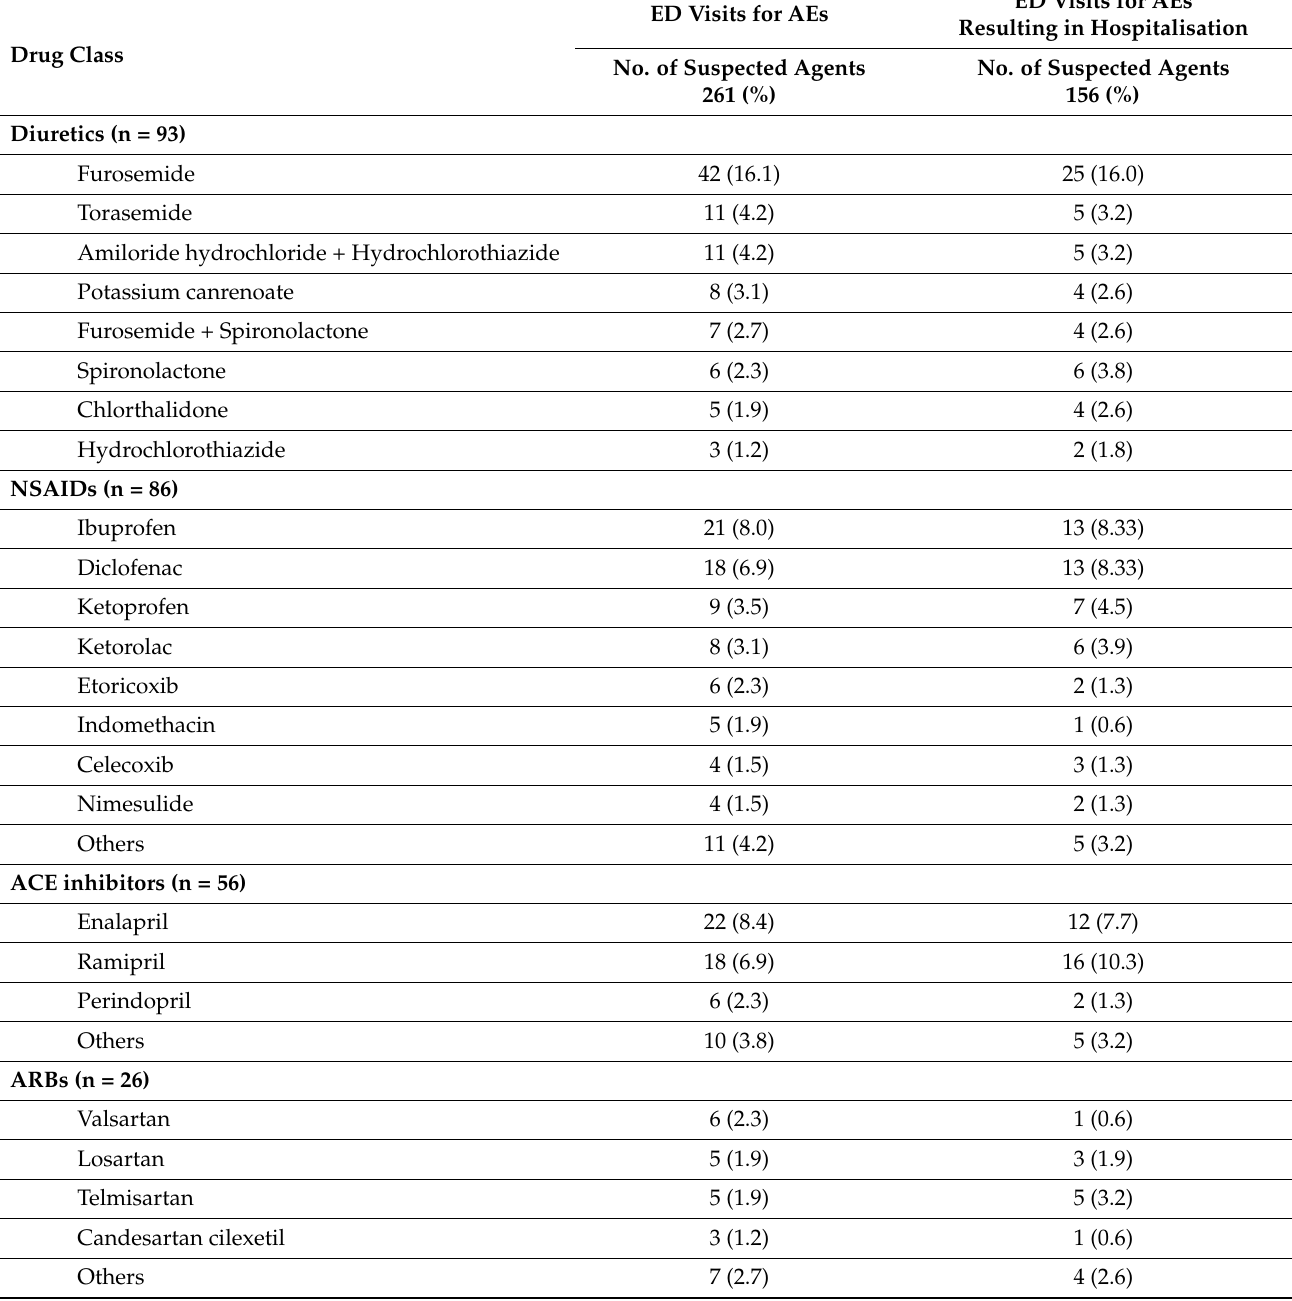
Table 2. Suspected pharmacological